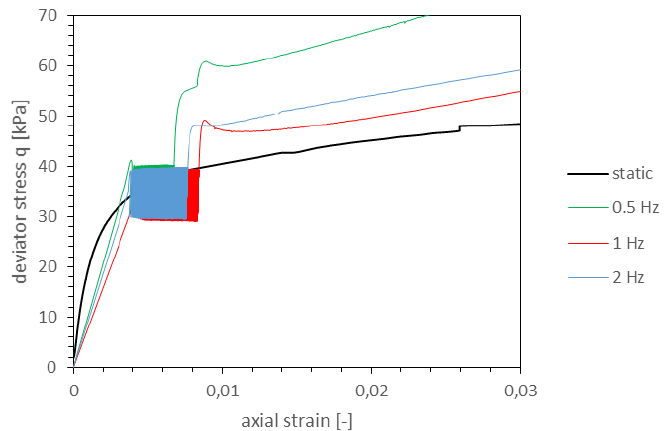
Figure 5. Results of triaxial tests on cohesive soil. The stress-strain characteristic for different frequency of loading.